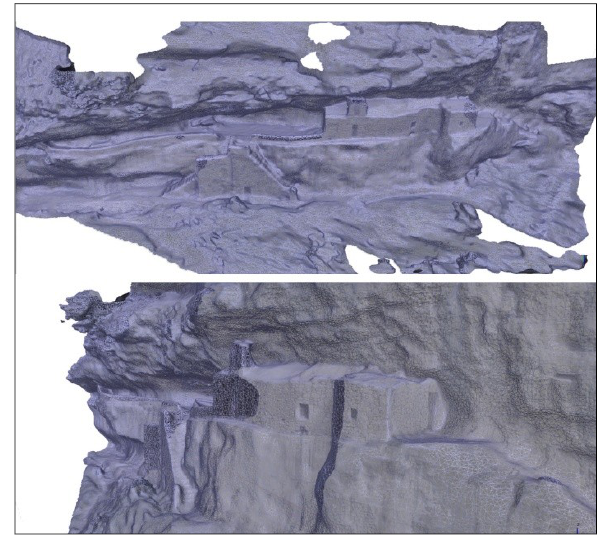
Figure 20. Correction of polygon meshes through specific tools